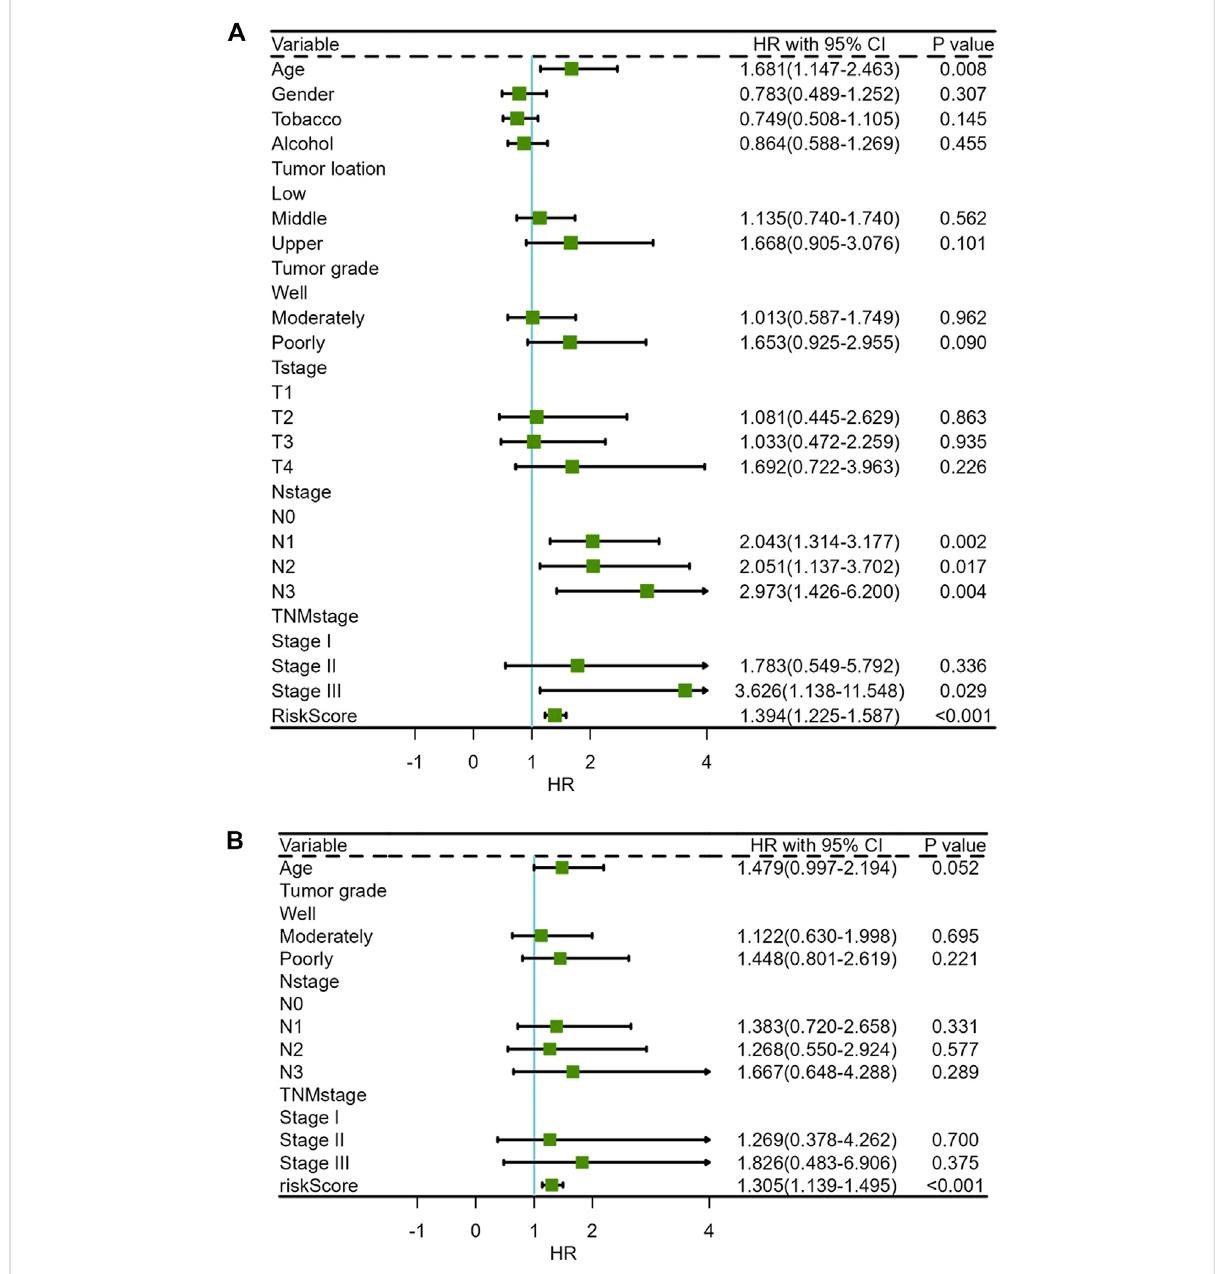
FIGURE 7 Forest plots of clinical characteristics and risk score for univariate and multivariate COX regression analysis (A) Univariate Cox regression analysis, (B) Multivariate Cox regression